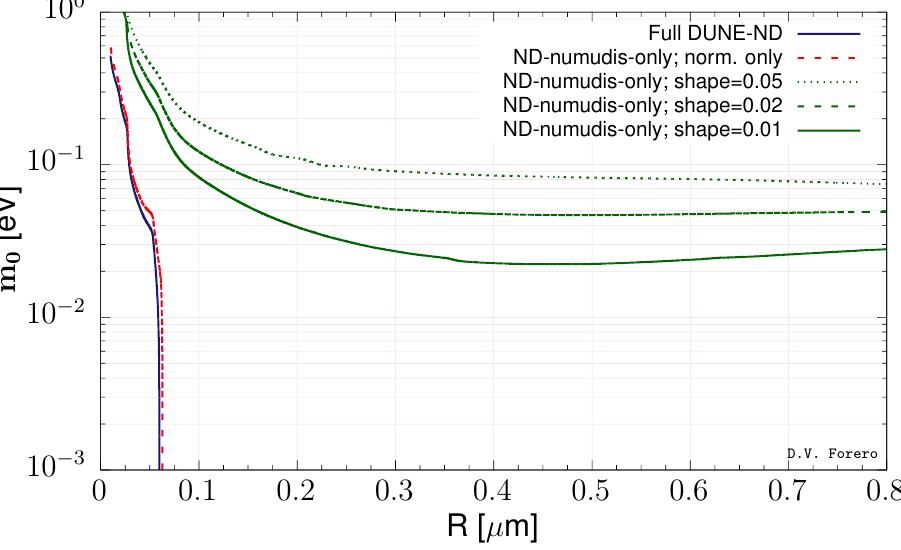
Figure 162. The 90 % CL exclusion regions for the LBNF with a ND with perfect spectral information (red and blue) and introducing an energy-dependent systematic (green) apart from the overall normalization uncertainties. Regions to the right of the blue and red curves, and above the green curves, are